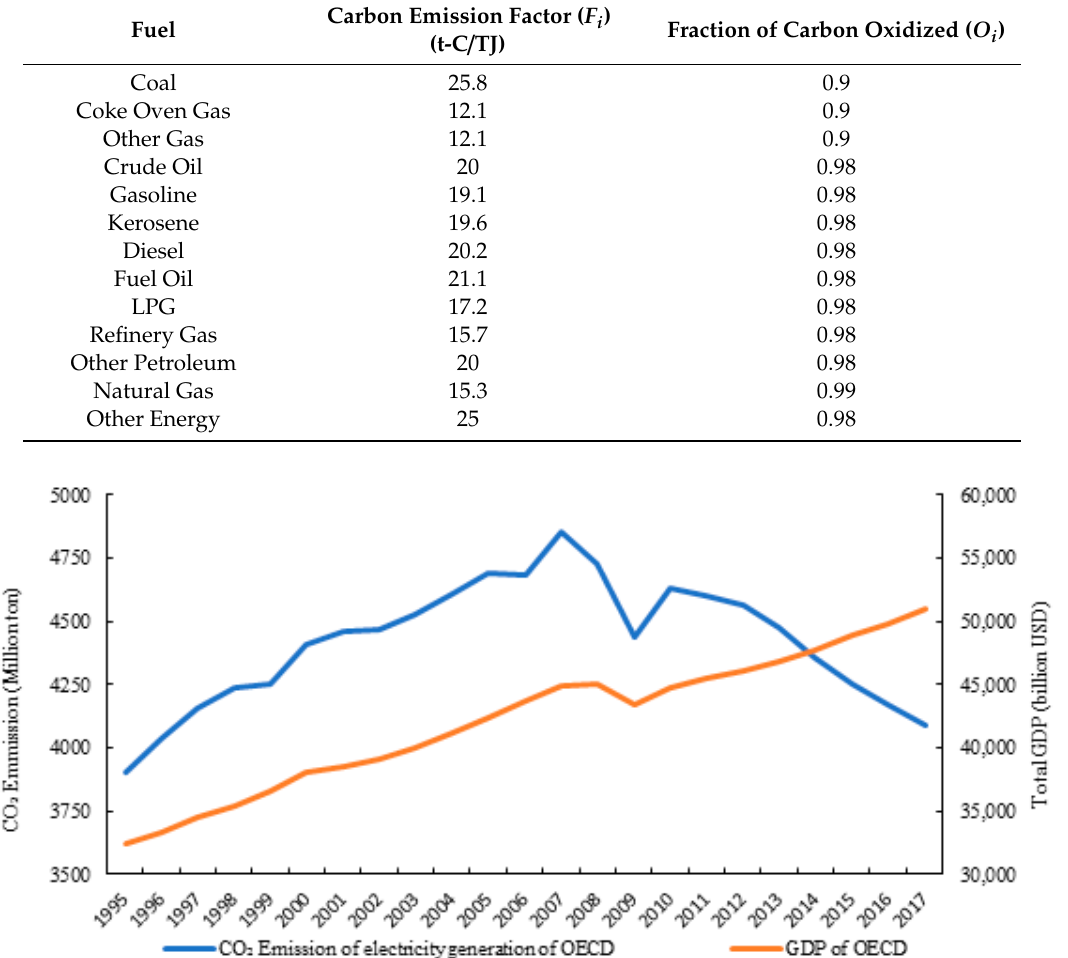
Figure 2. Total CO 2 emissions from electricity generation and GDP in OECD countries, 1995-2017. 171